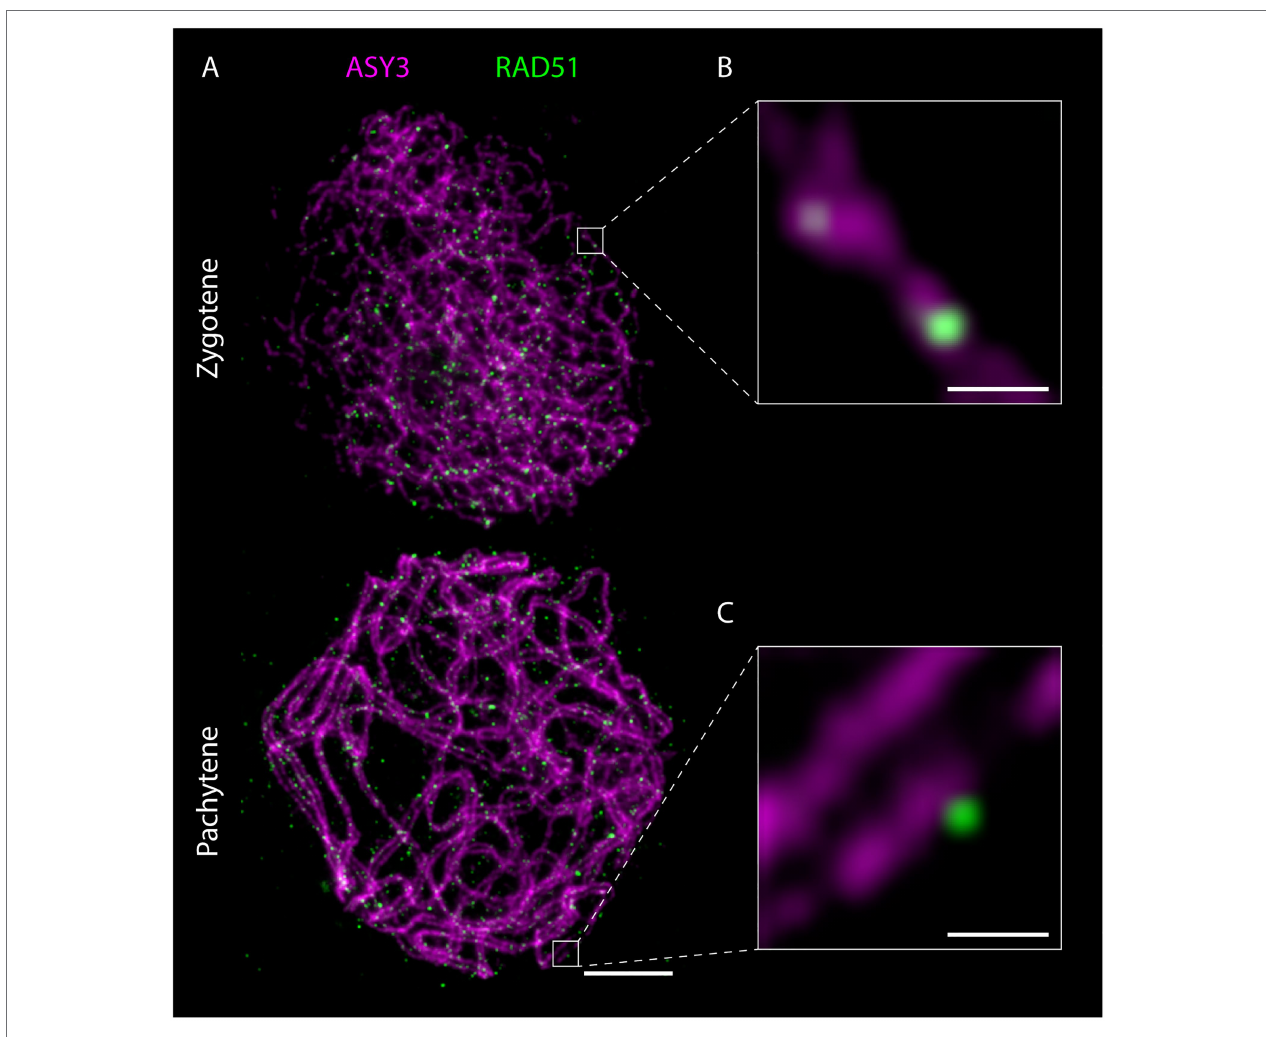
FIGURE 7 | Detergent-spread male meiotic nuclei were stained for the axial element protein ASY3 and the recombinase RAD51 and imaged with a STED nanoscope. Scale Bar: 2 μ m. Panels (B) and (C) show magnifications of the highlighted regions in panel (A) . Scale Bars: 200